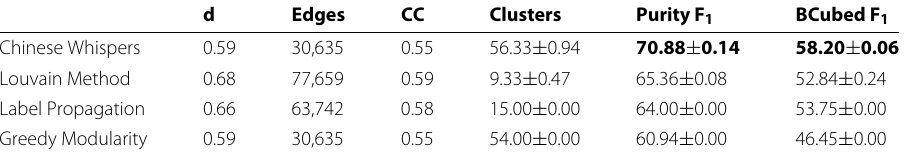
Table 8 Semantic role induction results achieved using different community detection algorithms d Edges CC Clusters Purity F 1 BCubed F 1 Chinese Whispers 0.59 0.68